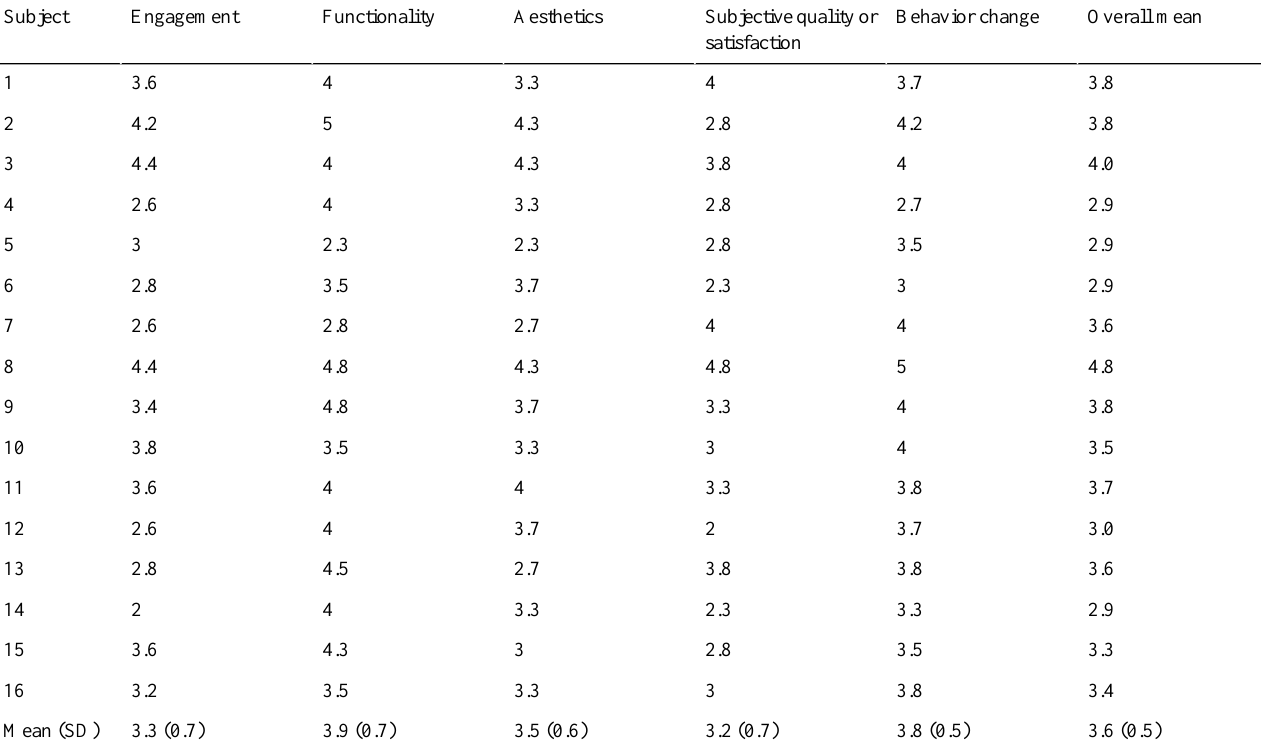
Table 1. Mobile App Rating Scale ratings for the TeamDoc